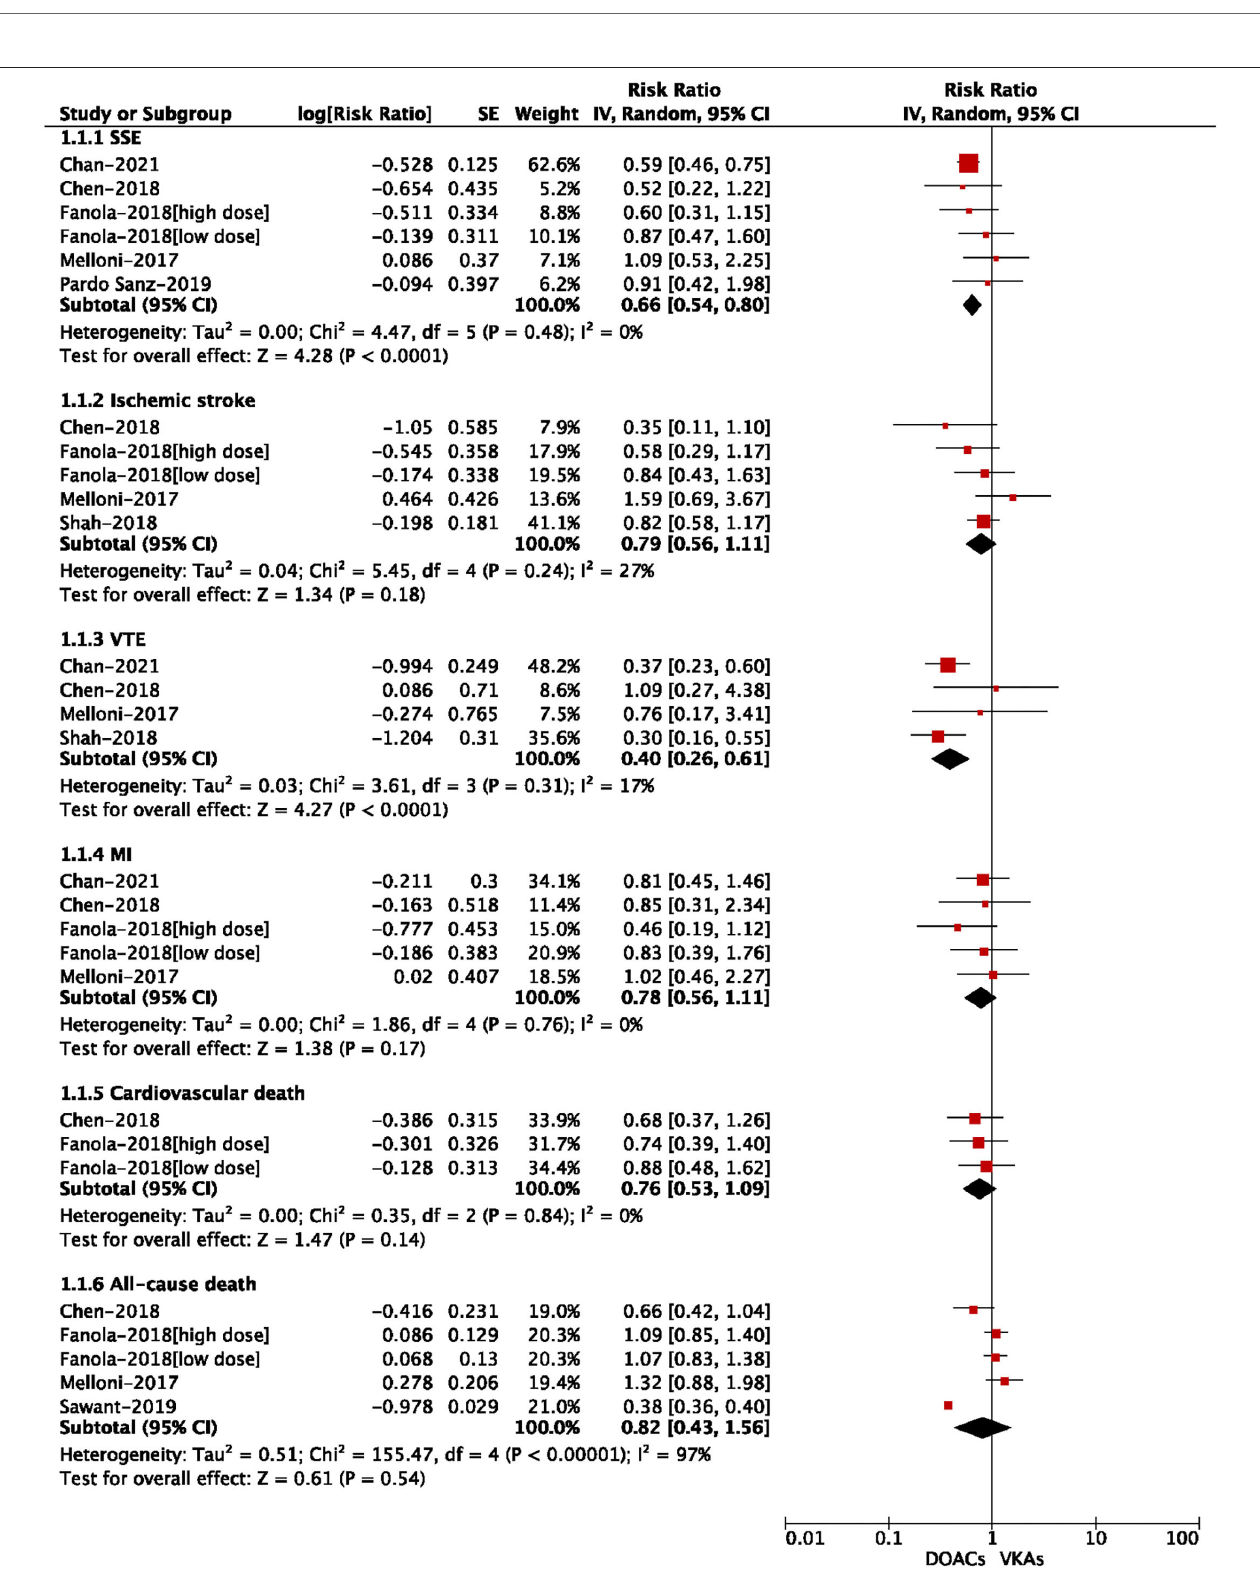
FIGURE 3 | Adjusted effectiveness data of direct oral anticoagulants compared with vitamin K antagonists among atrial fibrillation patients with cancer.